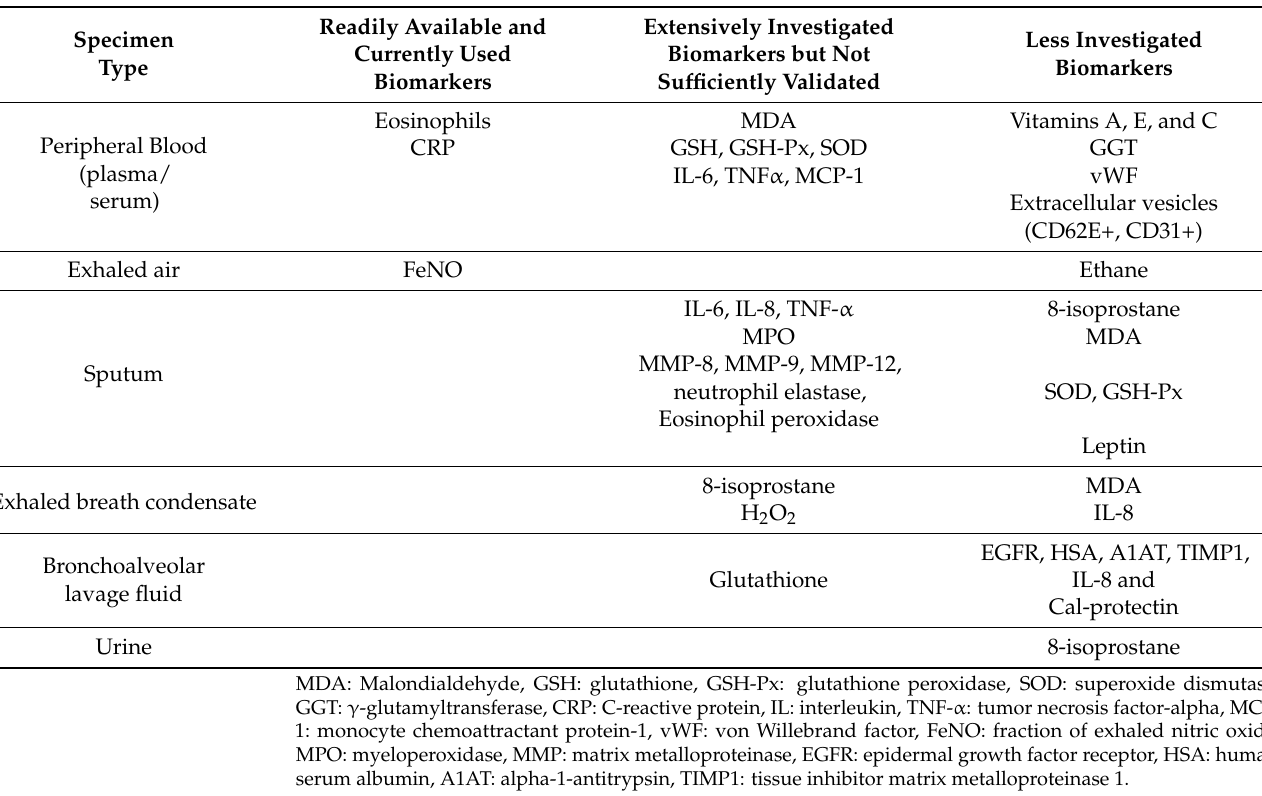
Table 1. Biomarkers under investigation for COPD